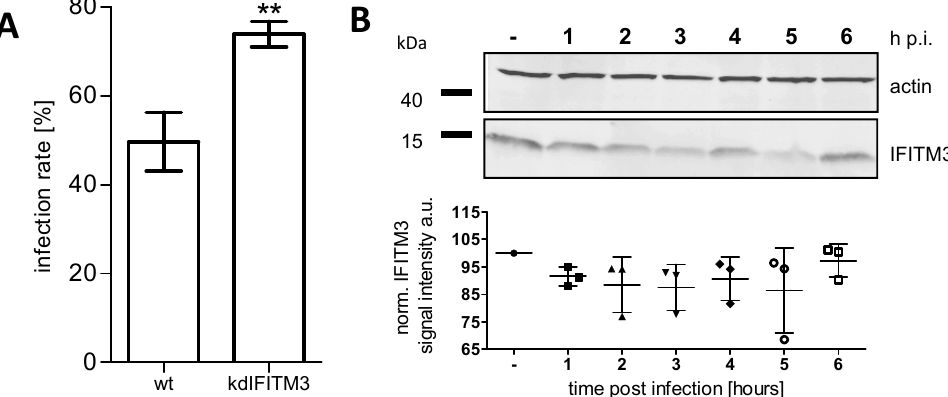
Figure 2. The effect of the IFITM3 knock-down on the influenza A virus (IAV) infection rate and the effect of IAV infection on IFITM3 expression levels. The A549 wildtype and IFITM3 knock-down cells subjected to immunofluorescence were infected with IAV A / Hong Kong / 1 / 1968 (MOI = 1) and fixed at 8 h p.i. The cells were stained using an anti-IFITM3 antibody in combination with anti-nucleoprotein. The image acquisition was performed using a 60 nm ( = confocal mode) pixel size. ( A ) The infection rate of A549 wildtype and IFITM3 knock-down cells was calculated based on immunostaining against IAV NP at 8 h p.i. Cells harboring nuclear NP signals were scored as IAV infected. The mean values of three independent experiments are plotted as the mean (SD). ( B , top) The immunoblot analysis of the IFITM3 levels in whole-cell lysates from non-infected (-) and A / Hong Kong / 1 / 1968 infected A549 wildtype cells (times post-infection, as indicated). Actin was used as the loading control. The panels are derived from a single cropped blot, with lanes 1–7 belonging to the same membrane and from the same experiment. ** p = 0.0044 ( B , bottom) The signal intensities of IFITM3 signals normalized for the actin control of three independent experiments. The mean values are plotted as the mean (SD). The IFITM3 levels are non-significantly different from each other.